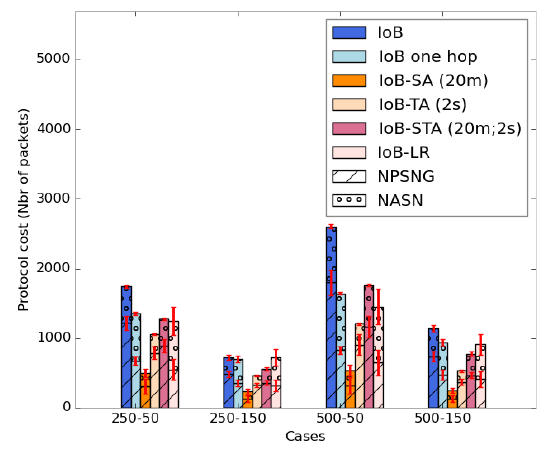
Figure 42. Average protocol cost